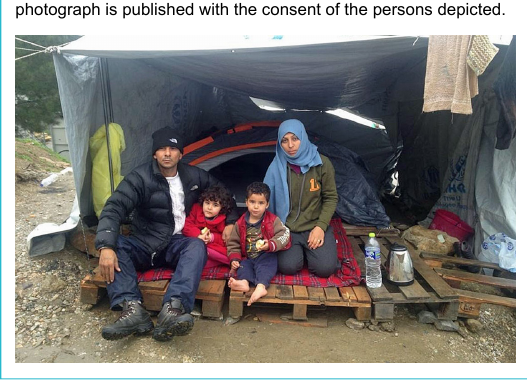
Figure 1: A refugee family currently living in Moria camp in front of their shelter. Photographer: Tricia Vannatter, health promoter; the photograph is published with the consent of the persons depicted.